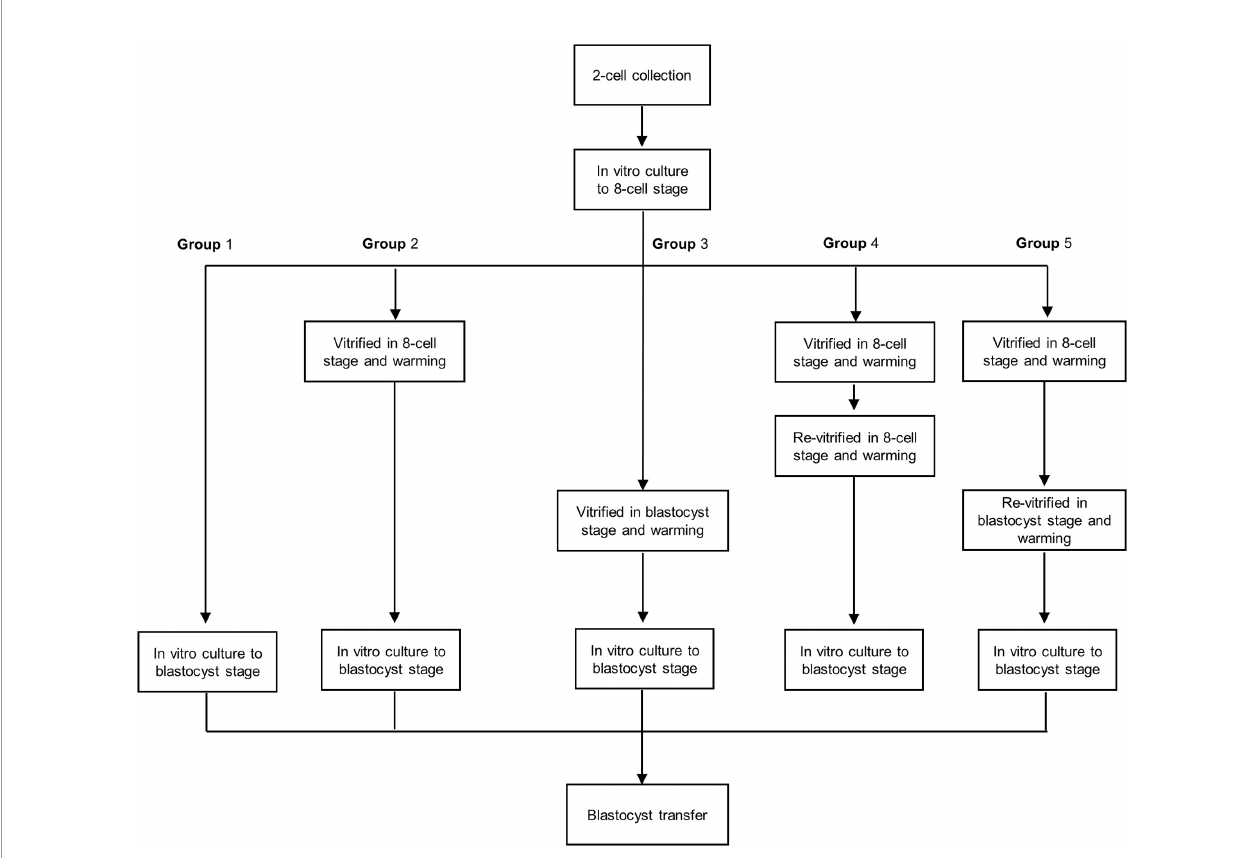
FIGURE 1 | Flow chart of the re-vitri fi cation process at different developmental stages in mouse embryos. Group 1: Fresh embryos; group 2: 8-cell vitri fi ed embryos; group 3: early blastocyst stage vitri fi ed embryos; group 4: vitri fi ed at the 8-cell stage twice; group 5: vitri fi ed at the 8-cell stage and re-vitri fi ed at the early blastocyst